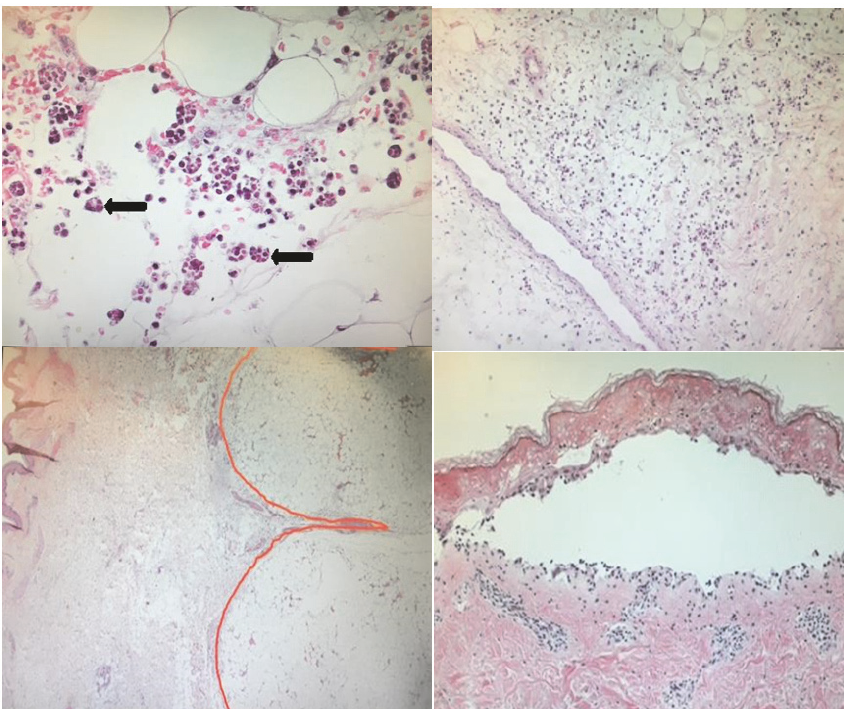
Figure 2: (a) The arrows indicate macrophages engulfing mostly the red blood cells (bean bag cells), (b) this is lobular panniculitis comprised of cellular infiltrate of lymphocytes, macrophages, and plasma cells, (c) septal panniculitis (highlighted), and (d) subepidermal bullous